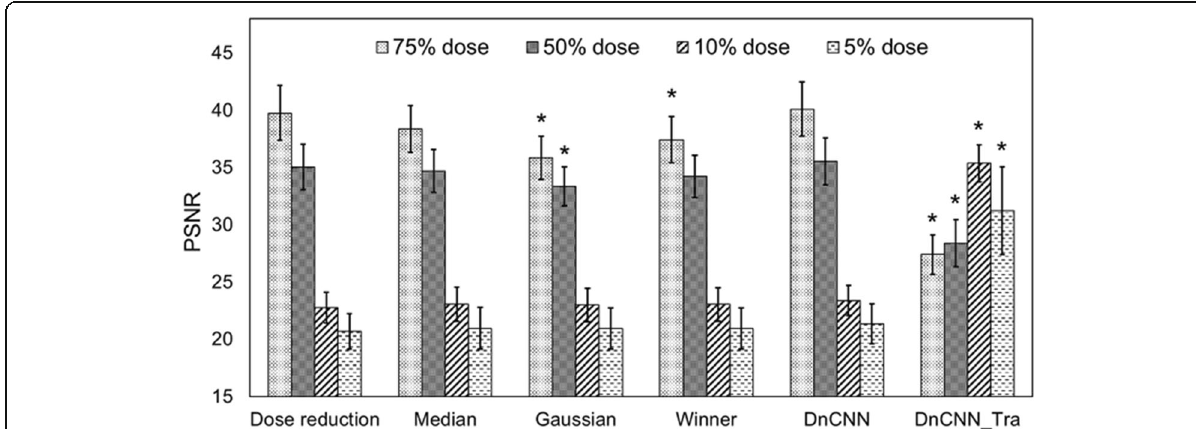
Fig. 7 PSNR results for different noise-reduction methods of each dose-reduction simulated image. * indicates p < 0.05, which represents a significant difference in PSNR value relative to the results of the original DnCNN